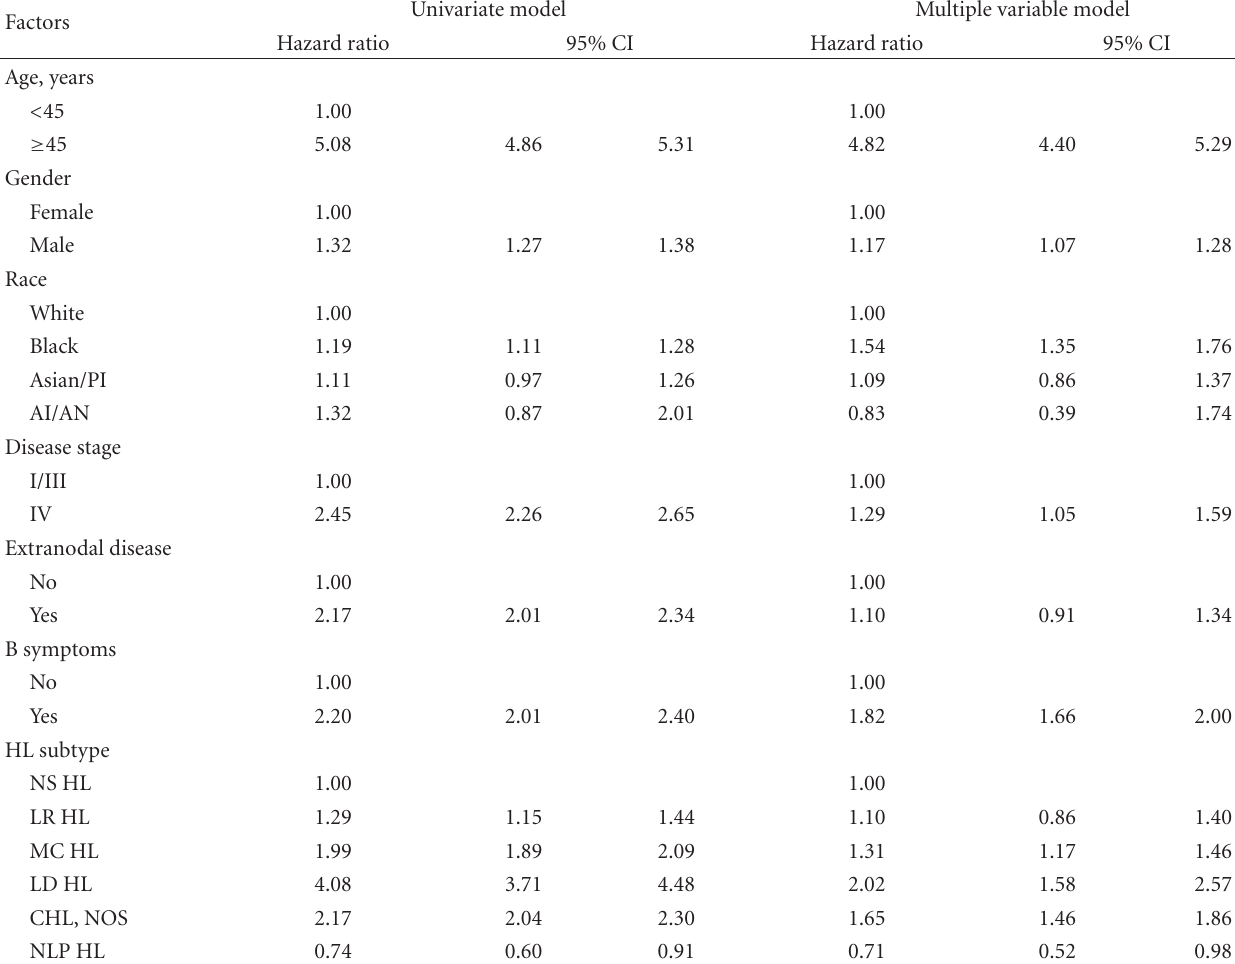
Table 3: Cox regression models of predictors mortality among Hodgkin lymphoma